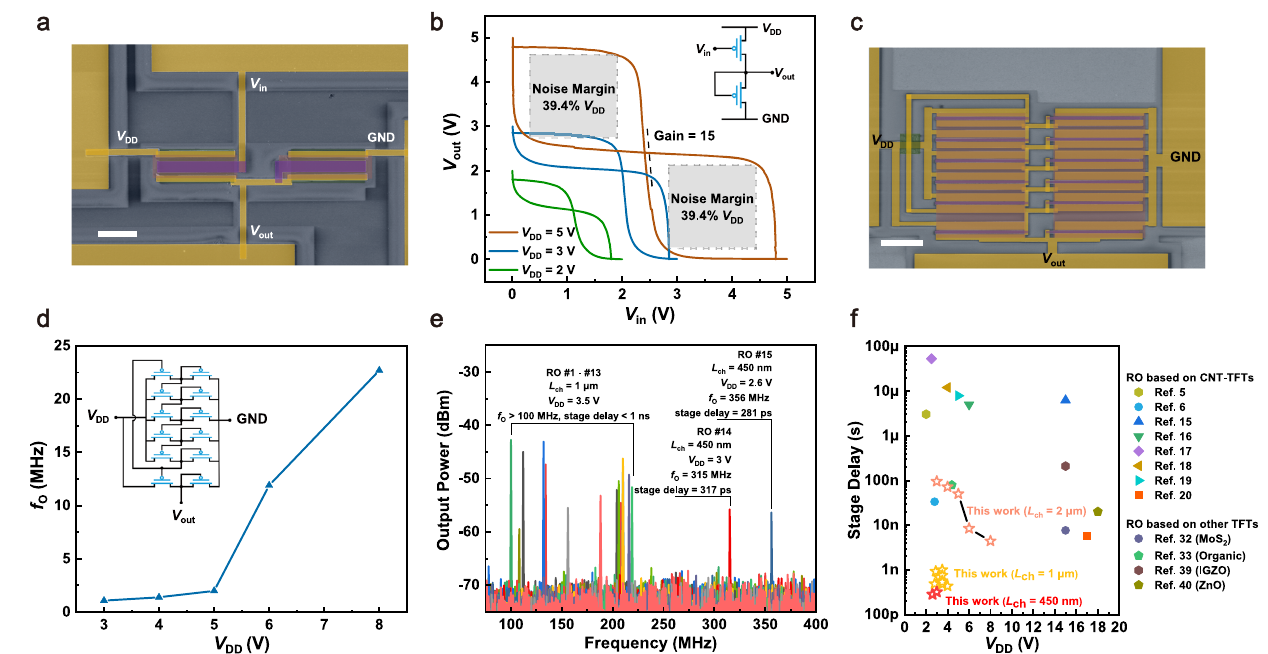
Fig. 5 | CNT-TFT-based fl exible inverters and ROs. a SEM image of an inverter based on TFTs with W ch / L ch =10 μ m/2 μ m. Scale bar, 10 μ m. b Voltage transfer characteristics and their mirrored curves of a representative inverter under dif- ferent supply voltages Inset, circuit diagram of the inverter. c SEM image of a 5-stageRObasedonTFTswith W ch / L ch =20 μ m/1 μ m.Scalebar,10 μ m. d Changein